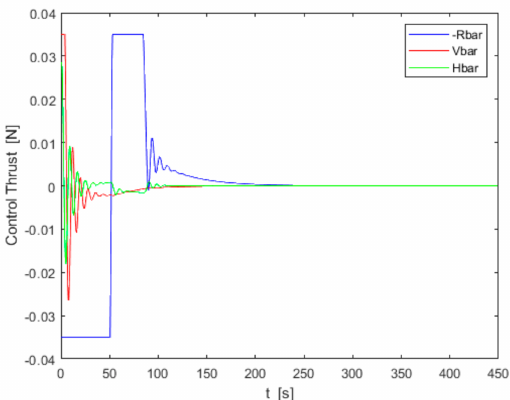
Figure 6. The control effort for the worst case at the initial conditions.